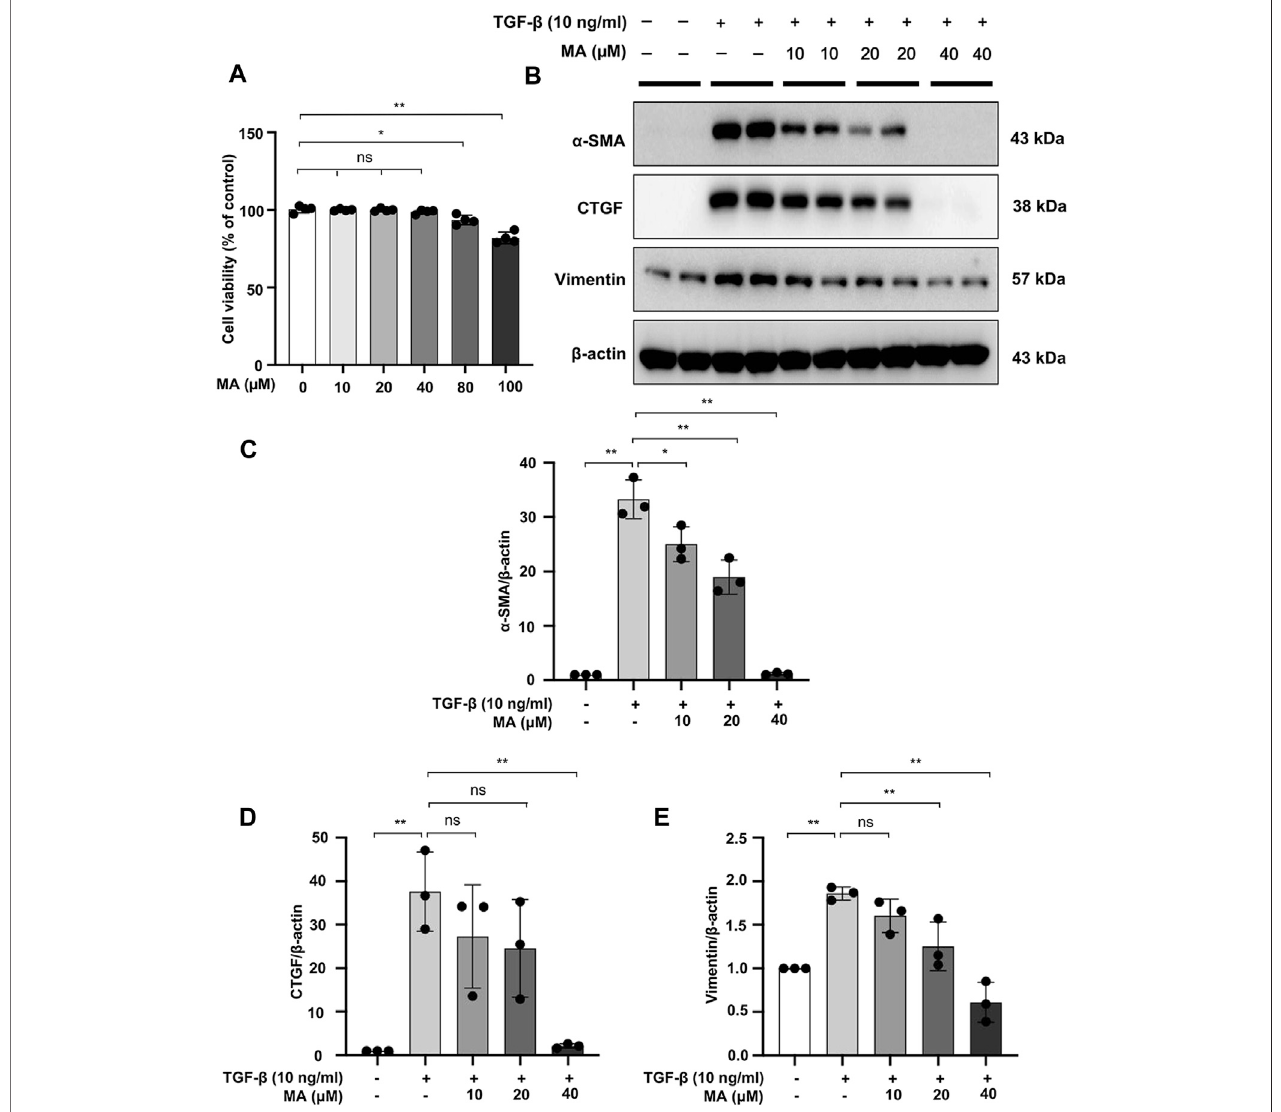
FIGURE 3 | MA attenuates TGF- β -stimulated fi brotic changes in NRK49F cells. (A) Cells were treated with MA for 24 h, and cytotoxicity assays were conducted. (B) Expression of α -SMA, CTGF, and vimentin in TGF- β -stimulated NRK49F cells was detected by western blot and quanti fi ed by densitometry. Cells were pretreated with MA for 2 h after starvation with 0.5% FBS medium, treated with TGF- β (10 ng/ml) for 30 min, and incubated in 5% FBS medium for 24 h. (C – E) The Statistical signi fi cance was presented as the mean ± SD, n (cid:1) 3. * p < 0.05, ** p < 0.01, ns: no signi fi cance. MA, maslinic acid.